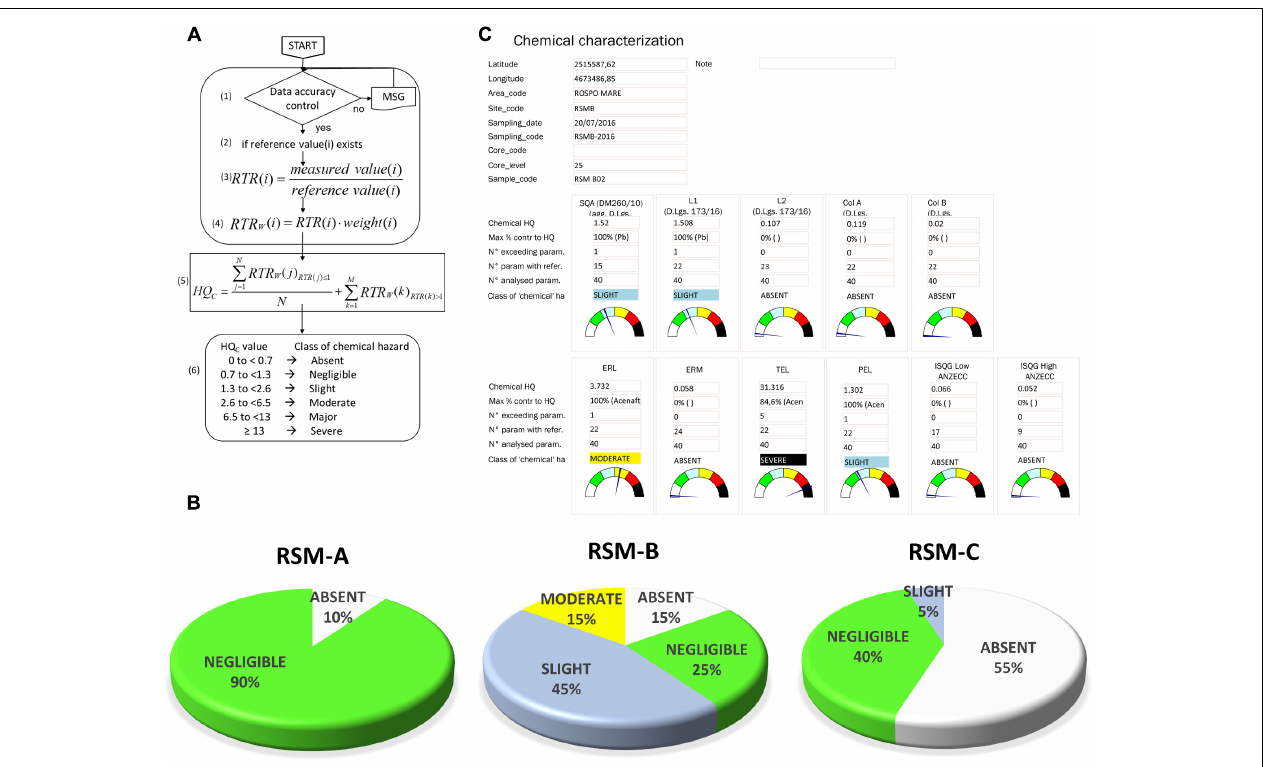
FIGURE 2 | LOE-1: elaboration of chemical results in sediments. (A) Flowchart and calculations of Chemical Hazard Quotient (HQ C ). (B) Results obtained for the three platforms indicating the percentage distribution of samples assigned to various classes of hazard considering European Sediment Quality Guidelines (EQS) as reference. (C) Model output of chemical characterization